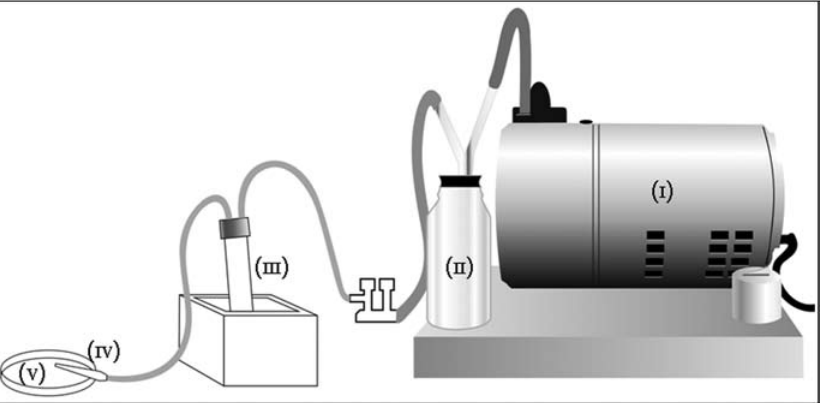
Fig. 1 . Instrument used to collect larval food by suction: (I) vacuum suction pump; (II) receptacle for the collection of waste; (III) food collector tube kept in ice; (IV) food suction hose and (V) petri dish to accommodate the brood cells.